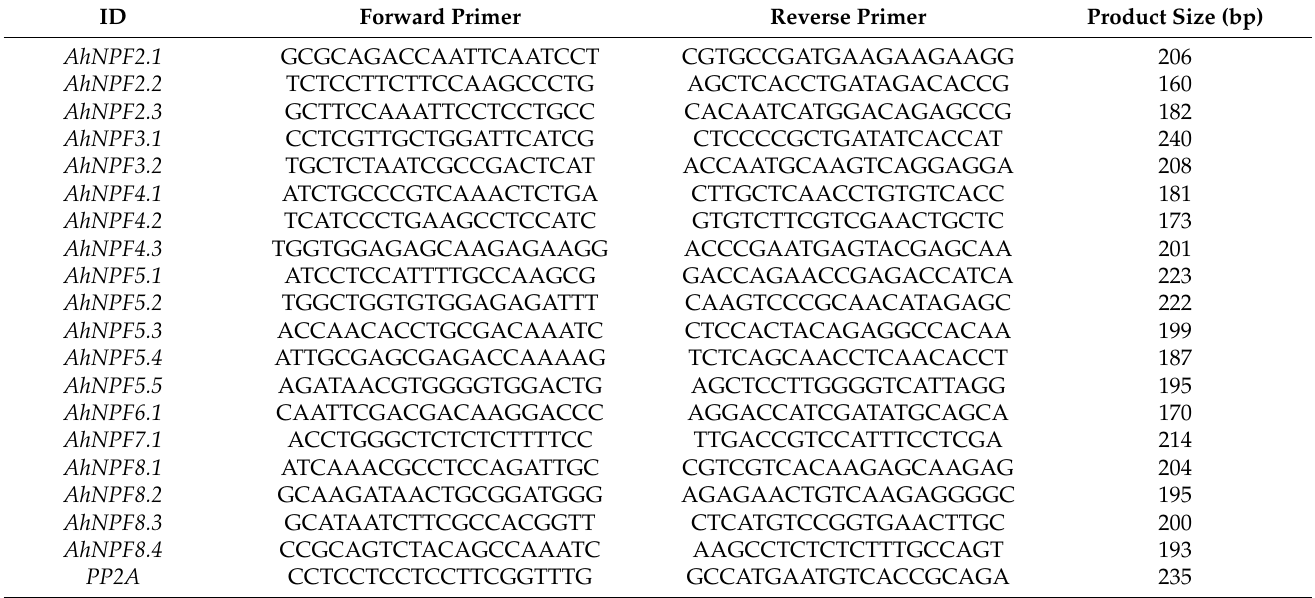
Table 2. Primers used for qRT-PCR